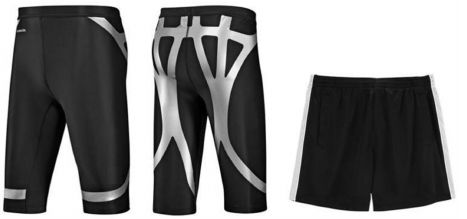
Figure 1. Compression shorts (CS) and control shorts